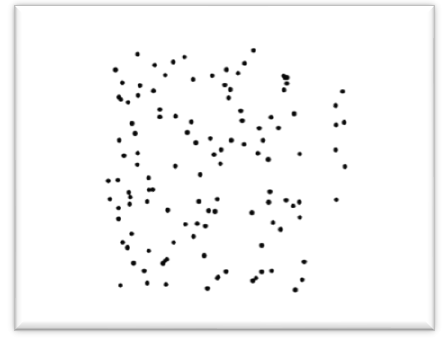
Figure 7. Example of Nodes Graph.